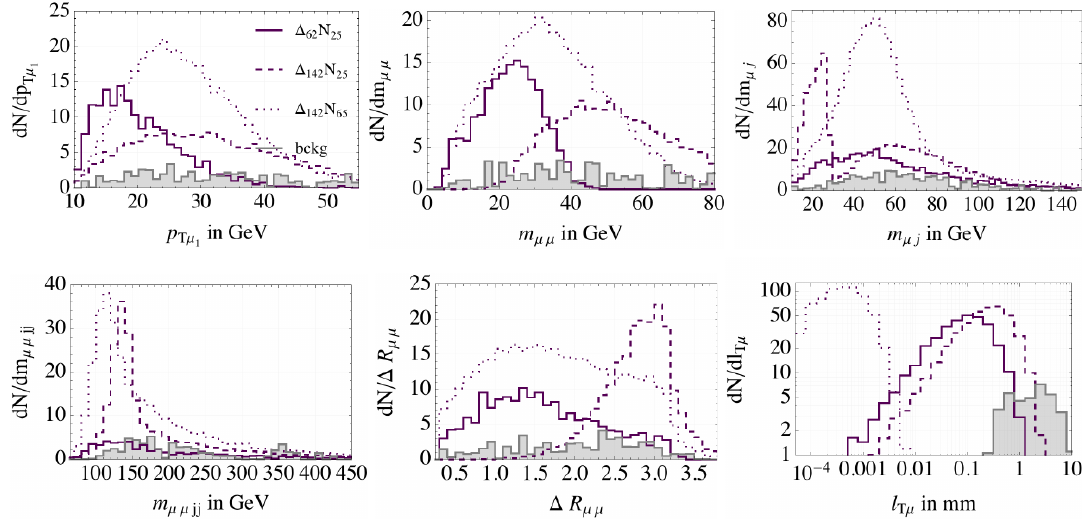
Figure 6 . Event distributions after basic cuts for three signal points m (cid:1) = (62 ; 142 ; 142) GeV and m N = (25 ; 25 ; 65) GeV in solid, dashed and dotted lines. Throughout, M W p s = 13 TeV ; L = 100 fb (cid:0) 1 . The gray shaded area corresponds to the sum of genuine backgrounds: ttX , V X and WWjj as in table 1. In the lepton displacement plot (bottom-right) its non-prompt component is evident, while the prompt component is outside the plot, at zero